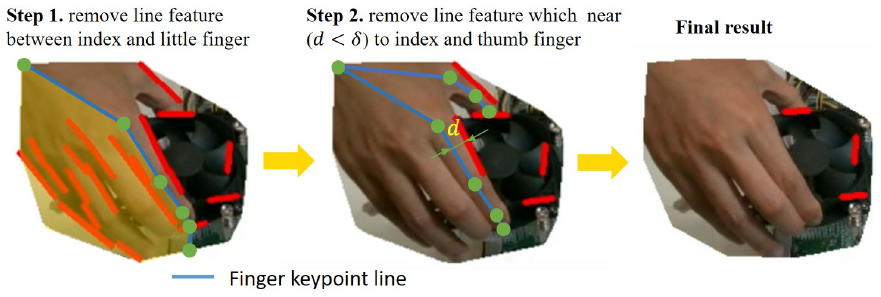
Figure 4. Remove noise line features that belong to the hand.